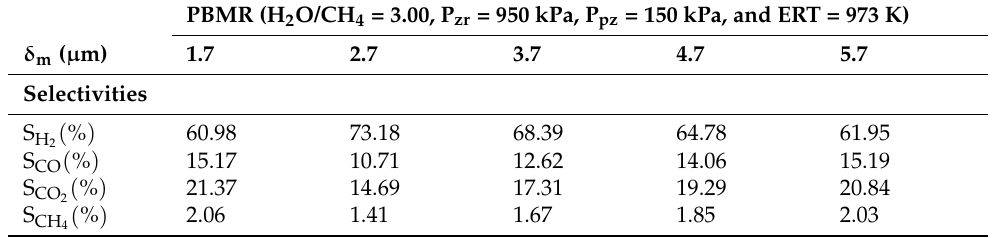
Table 6. Selectivity of H 2 , CO, CO 2 , and CH 4 as a function of the dense membrane thicknesses ( δ m